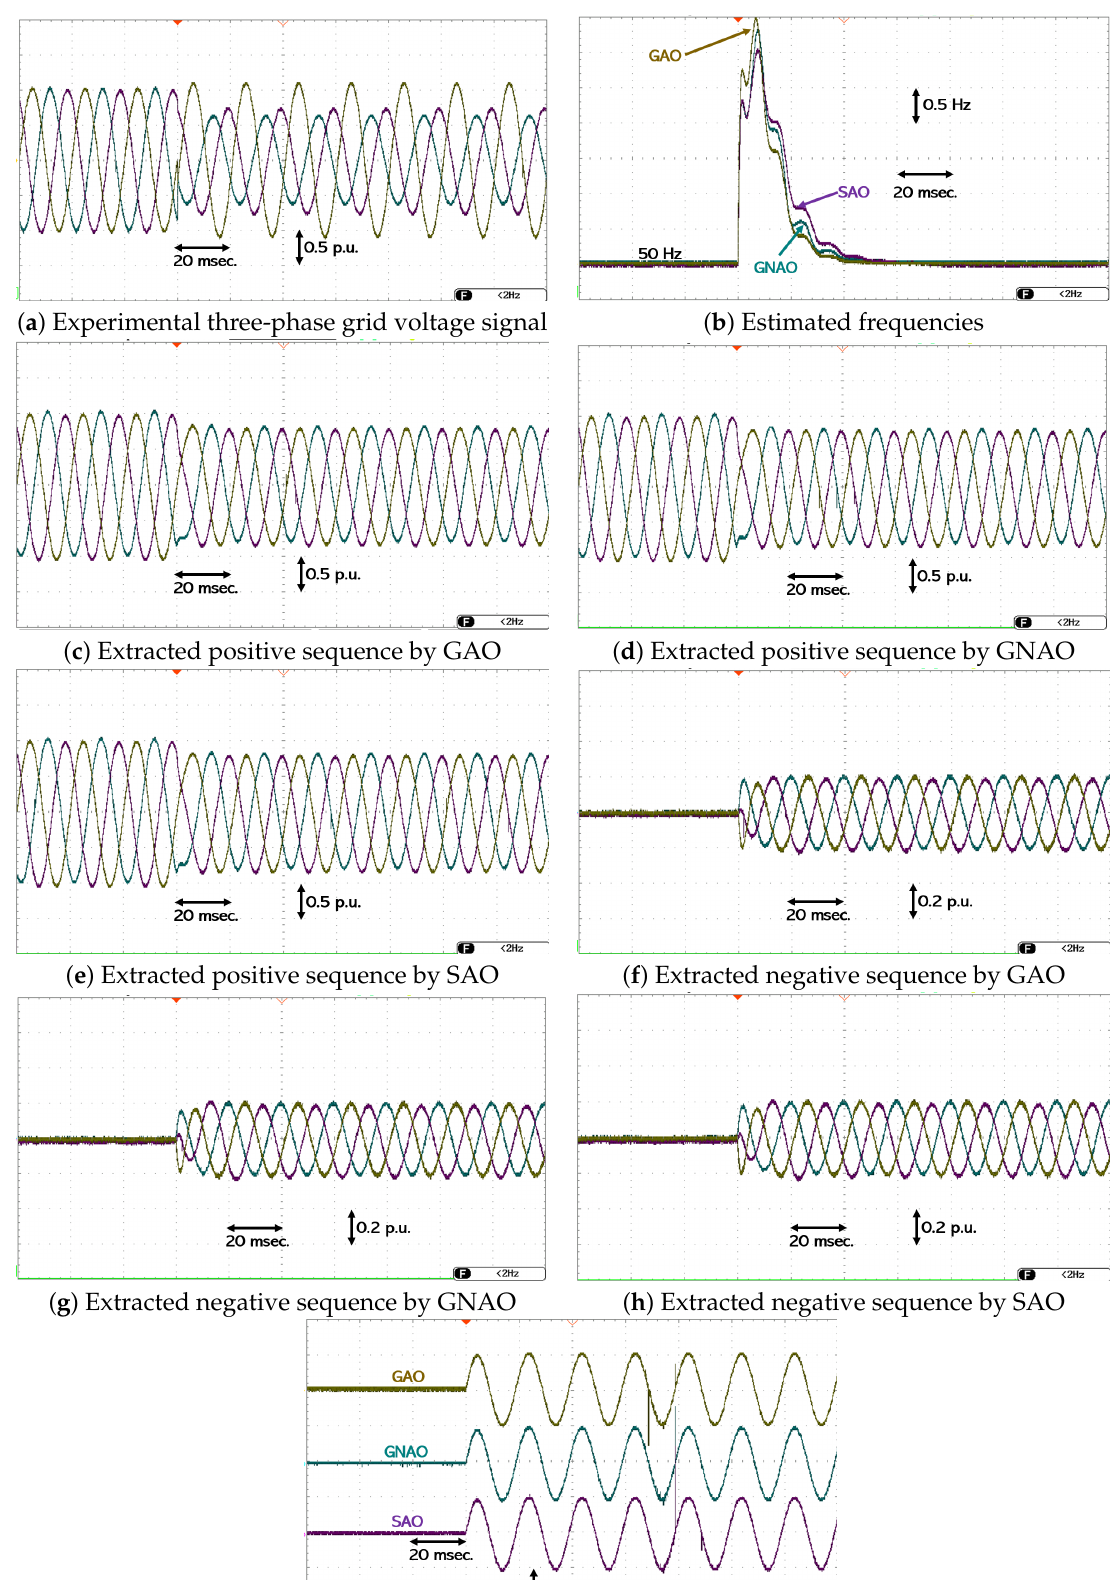
Figure 6. Experimental results for balanced to unbalanced